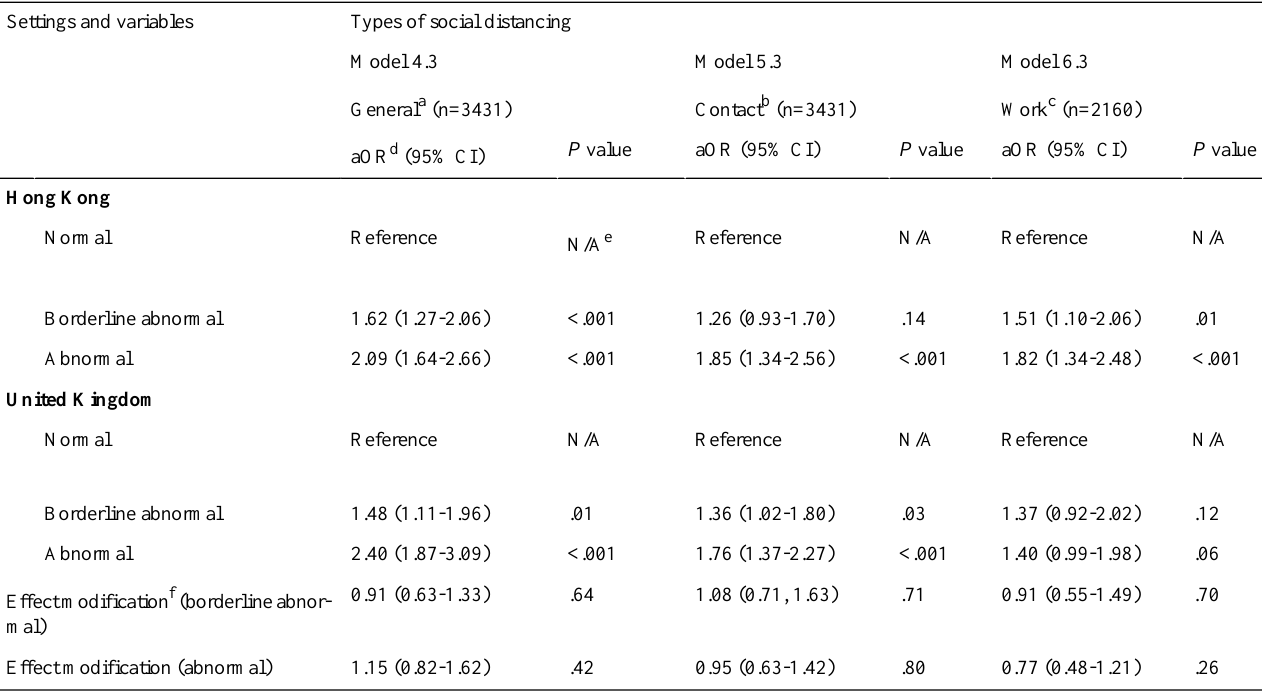
Table 6. Setting-specific effects and effect modification (by setting) of anxiety level on the adoption of social distancing measures. The models have been adjusted for all